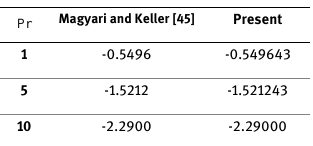
Pr Magyari and Keller [45]